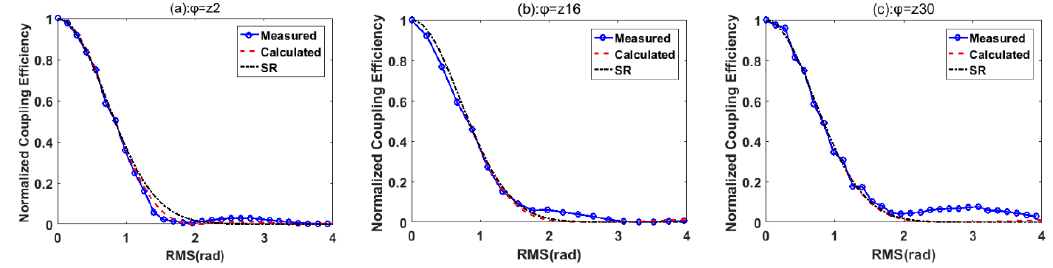
Figure 12. Relation between tilt-coma terms and CE. ( a ) φ = Z2; ( b ) φ = Z16; ( c ) φ = Z30.